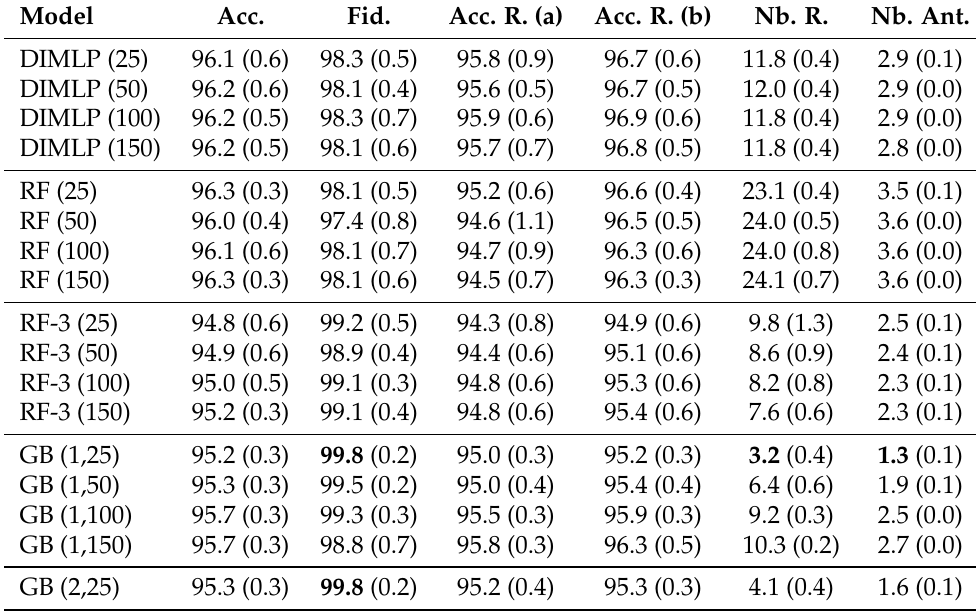
Table 9. Average results obtained on the “Voting” dataset. For each column, the highest average accuracy or average fidelity is represented in bold, along with the lowest average number of rules or average number of